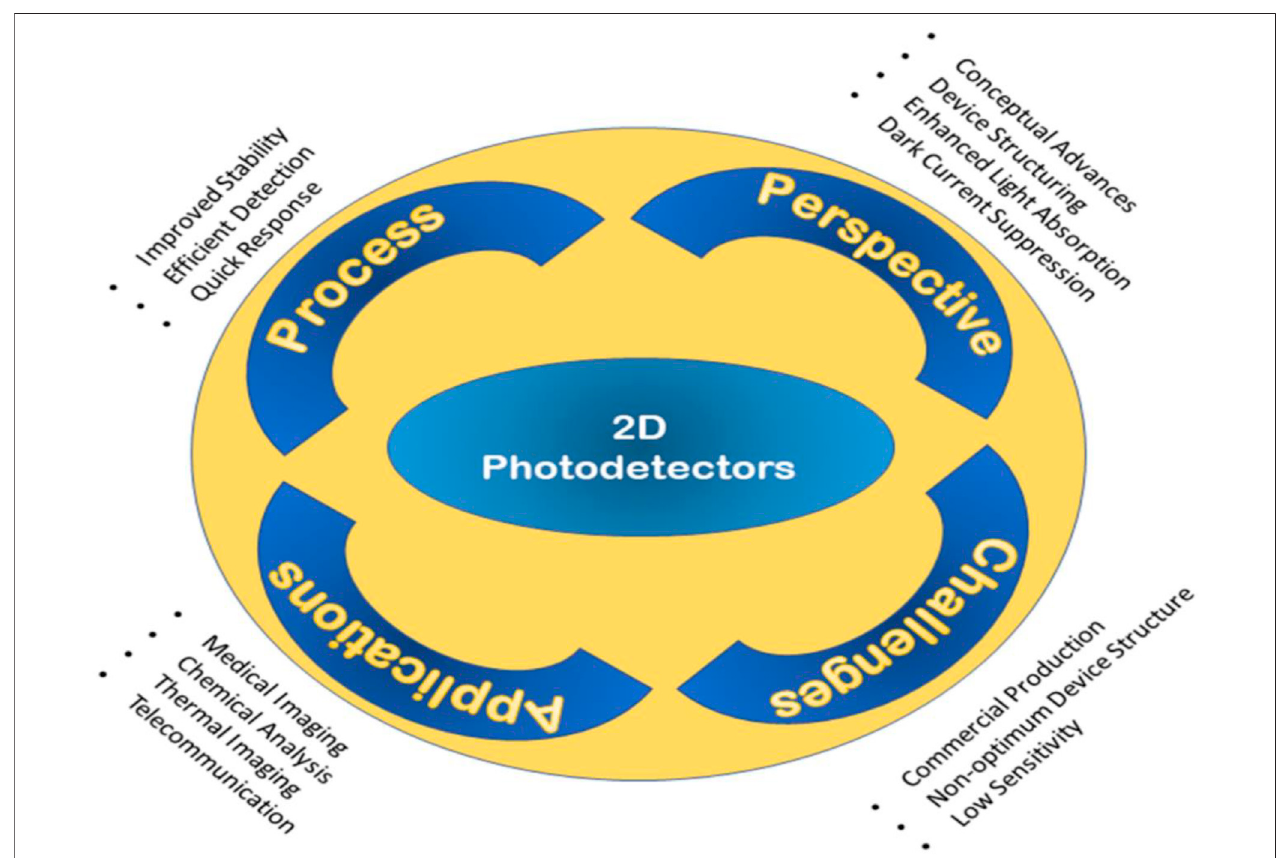
FIGURE 18 | 2D materials-based photodetector processes, perspectives, challenges, and applications.